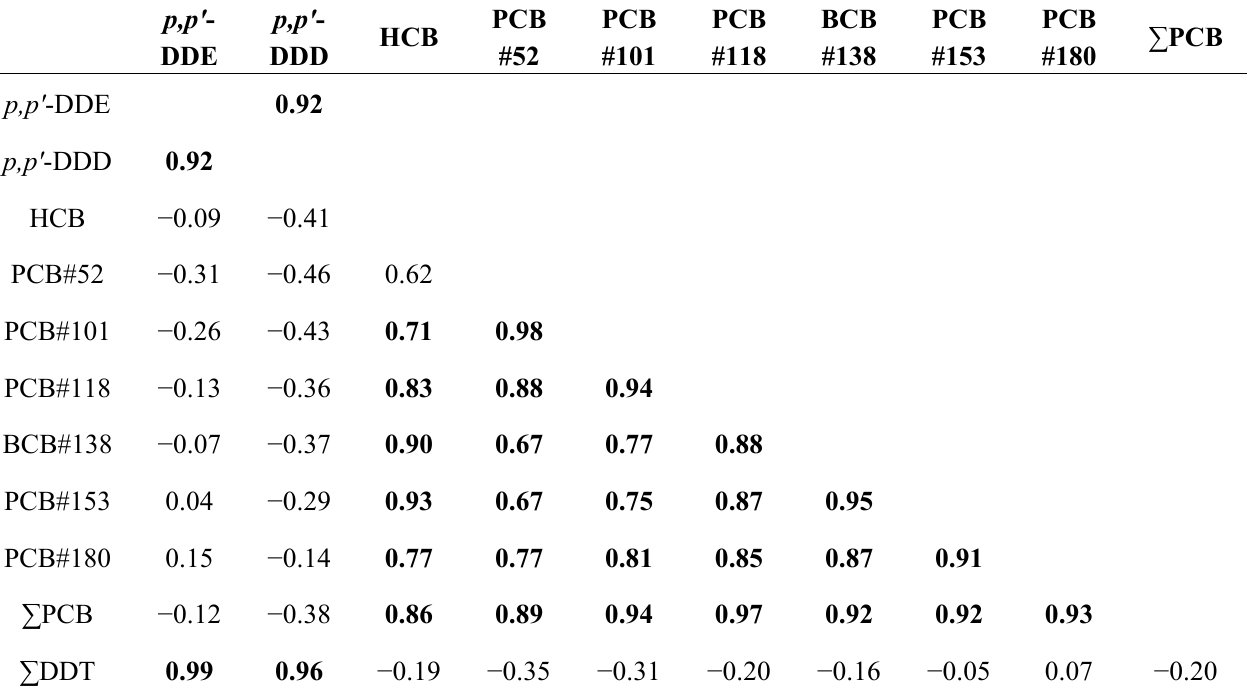
Table 2. Correlations (r; Pearson) between the analyzed POPs. Correlations with significance p < 0.05 are indicated with grey background, those with p < 0.01 are indicated in bold